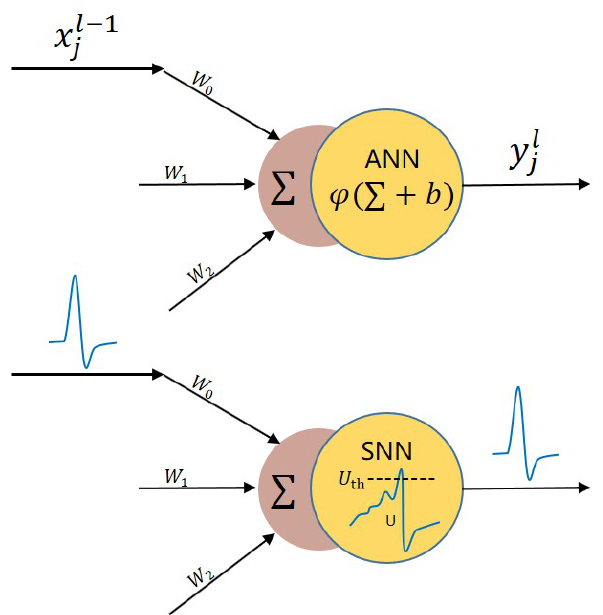
Figure 2. Source artificial neural networks (ANN) and target